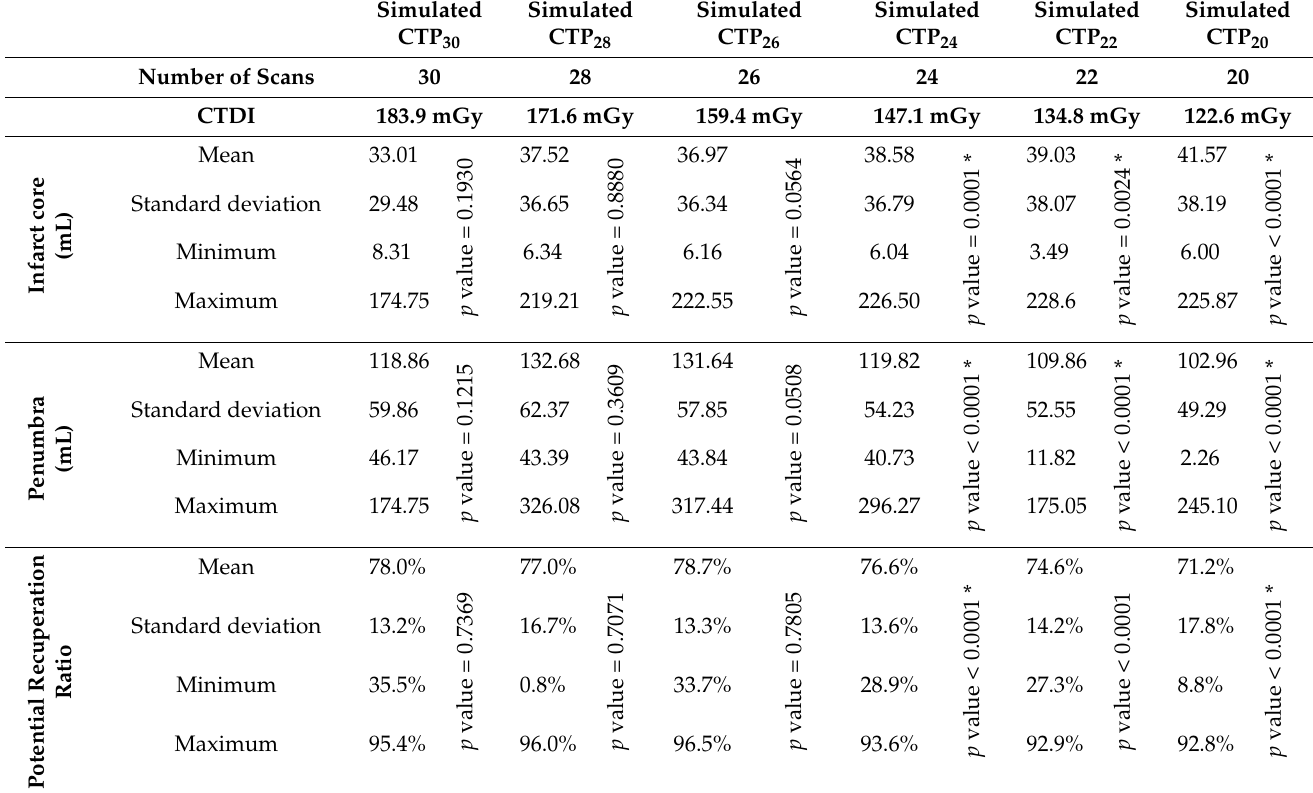
Table 1. The data of the volumetric calculations of the shortened simulated CTPs are given as the mean value, standard deviation, minimum and maximum, including p -values and the data of radiation exposure as the CT dose index (CTDI). Significant p values are marked with *. Simulated Simulated Simulated Simulated Simulated Simulated CTP CTP 22 CTP 24 CTP 26 CTP 28 CTP 30